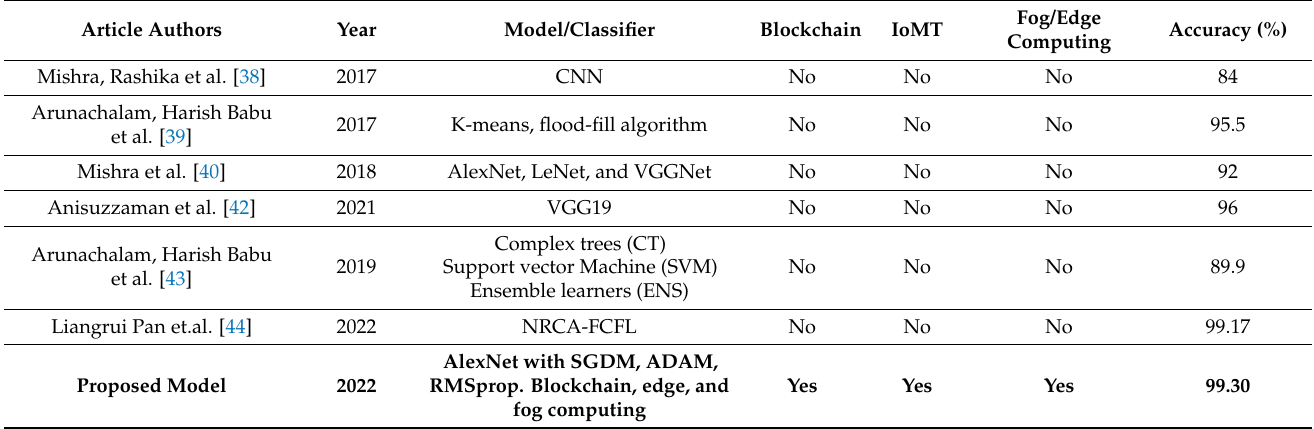
Table 7. Comparison of the proposed model with state-of-the-art